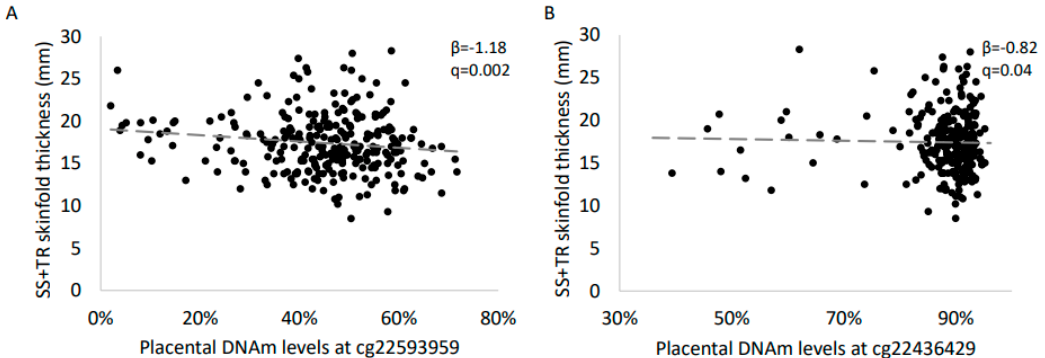
Figure 1. Epigenome-wide single-site associations between placental DNAm levels and childhood adiposity. ( A ) Volcano plot and ( B ) Manhattan plot shows the CpG-by-CpG analysis results of investigations between placental DNAm levels and children’s sum of skinfolds (subscapular + tricipital) in Gen3G participants. The False Discovery Rate (FDR) correction for multiple testing threshold ( q < 0.05) is represented by a yellow doted-line in the Volcano plot and a blue line in the Manhattan plot, whilst the red line is the Bonferroni-corrected threshold ( p < 1 × 10 − 7 ) in both graphs.